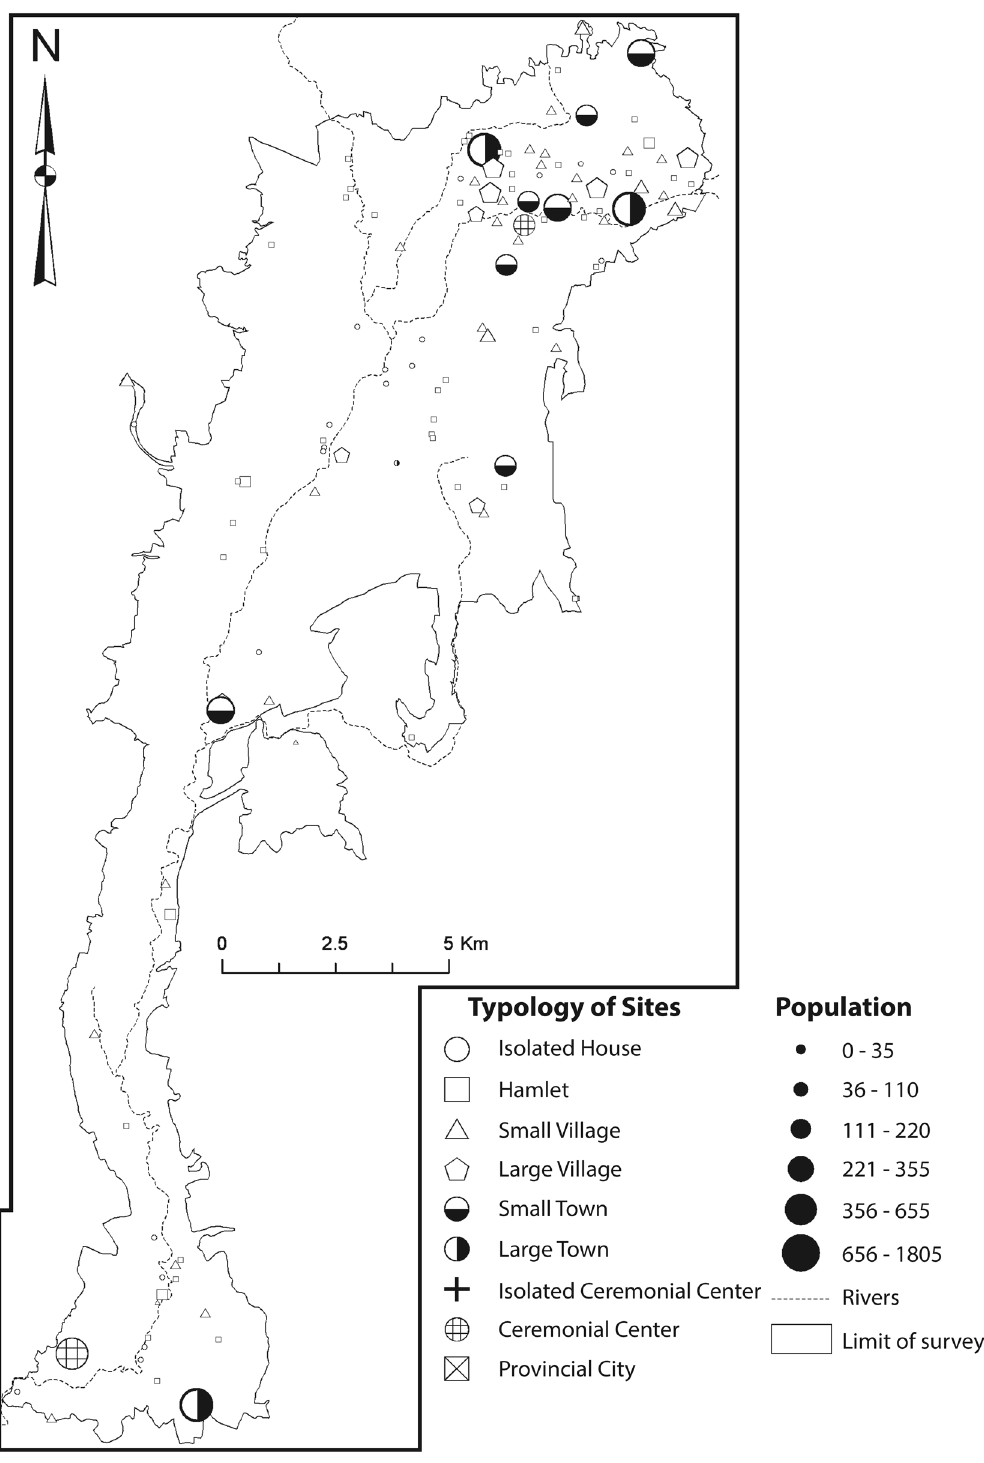
Figure 12: Settlement patterns of the Epiclassic